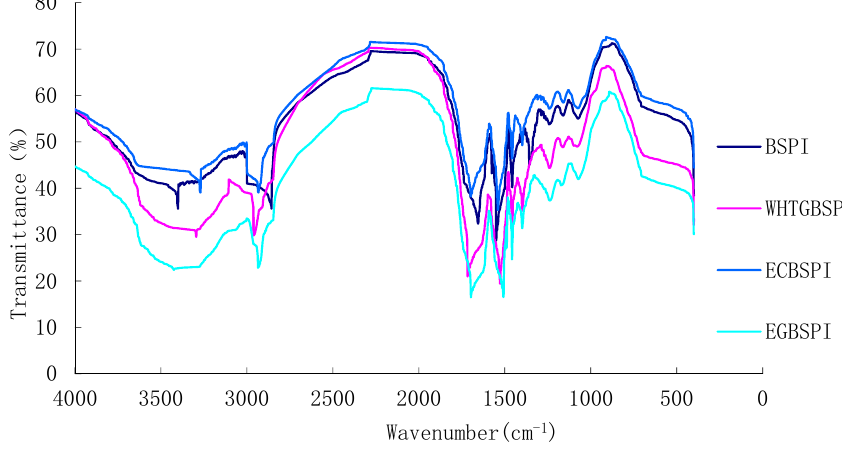
Figure 2. Comparison of FT-IR spectra of BSPI and its modified products.